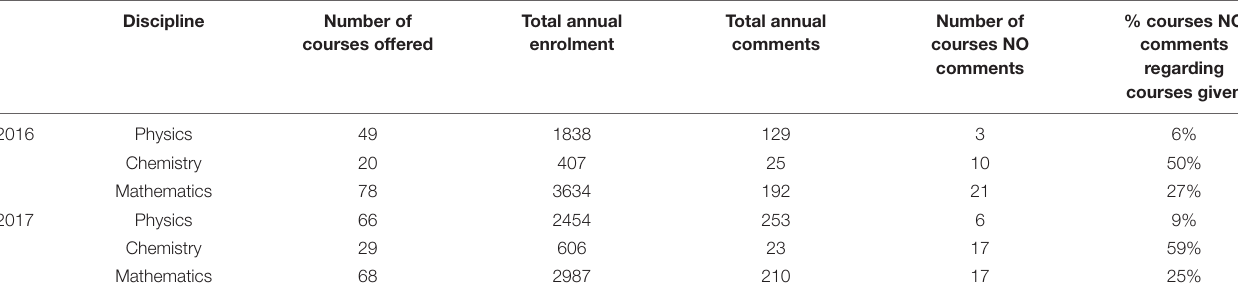
TABLE 3 | Characterization of the comments by discipline, 2016 and